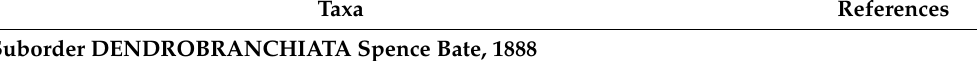
Table 2. Updated checklist (December 2019) of the order Decapoda Latreille, 1802 recorded from the Rhodes Island area (Greece, eastern Mediterranean) with references to first records. Alien species are marked with an (A) after the scientific